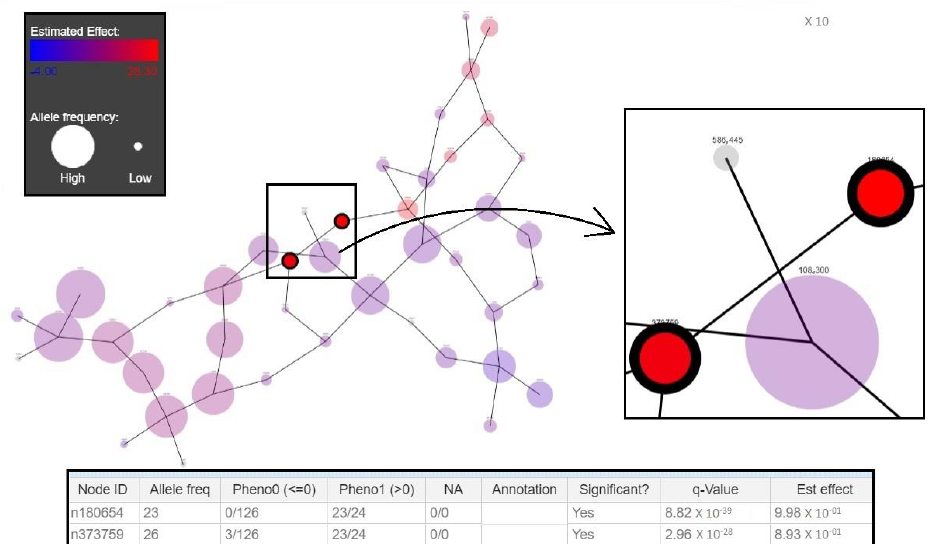
Figure 2. Compacted De Bruijn graphs (cDBG) generated by De Bruijn graph-based Genome Wide